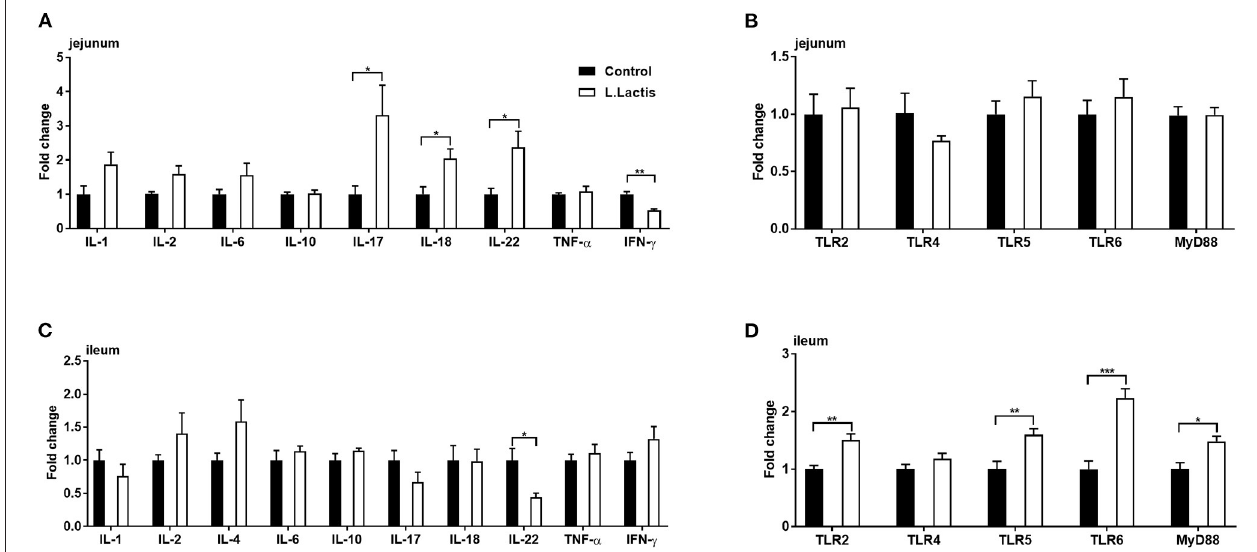
FIGURE 3 | Jejunal and ileal mRNA expression of immune-related factors. Relative gene expression of (A,C) IL-1, 2, 4, 6, 8, 10, 17, 18, 22, TNF- α , and IFN- γ , and (B,D) TLR-2, 4, 5, 6, and MyD88 were analyzed by RT-PCR (jejunal IL-4 was undetected). An unpaired t -test was used for analyzing the data (mean ± SEM).